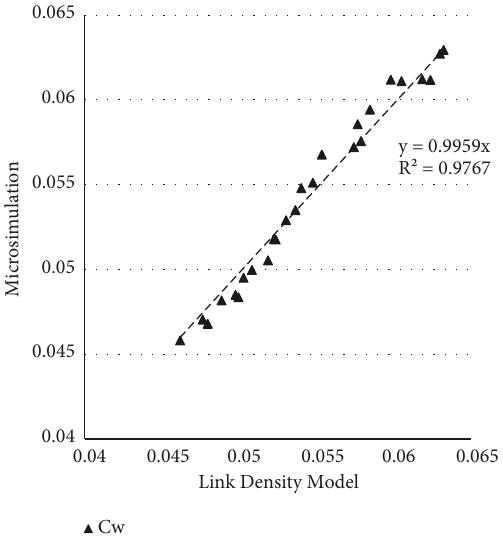
Figure 14: Dispersion of No. of Vehicles on Links: Microsimulation vs Density-Based Model.